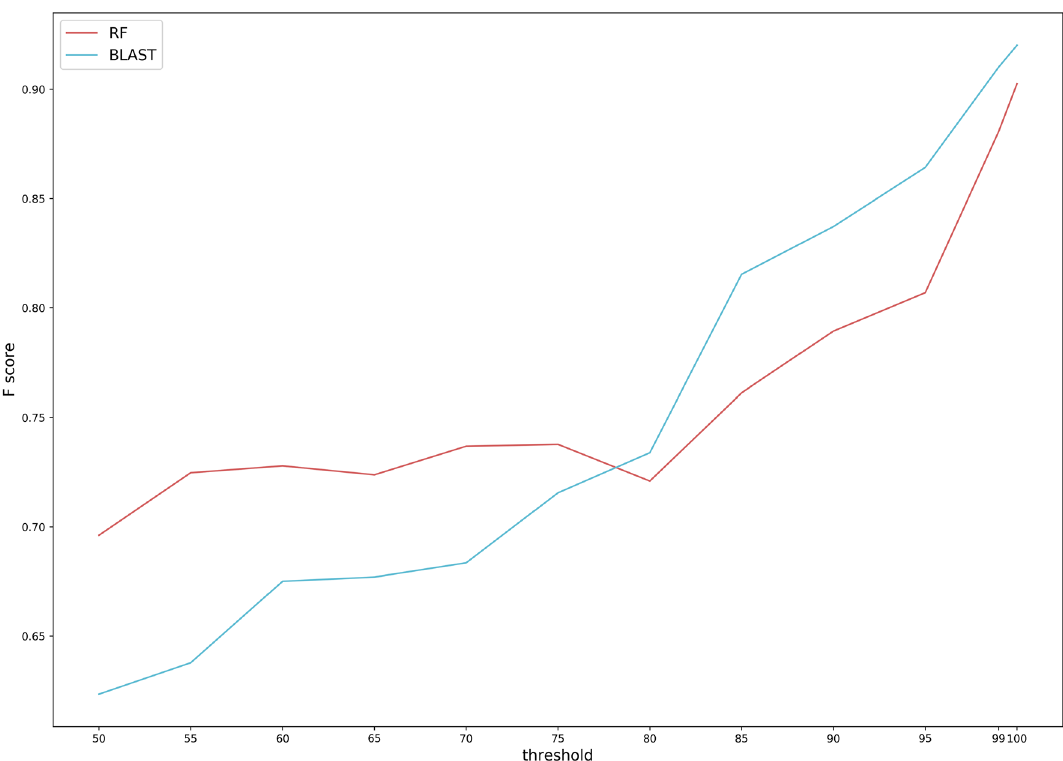
Figure 8. Computed F1 scores of the final Random Forest (RF) model and BLASTp in a Leave-One-Group-Out Cross-Validation (LOGOCV) across different thresholds for sequence similarity. Our final predictive model was compared with BLASTp using a LOGOCV scheme. In every round, a group was held out that was controlled by sequence similarity. The model was trained on all other sequences, after which the bacterial hosts related to the held-out group were predicted. The sequences in this group were also subjected to a local BLASTp search via BioPython against the database without the held-out group 36 . The LOGOCV was repeated for different thresholds of sequence similarity in the dataset that controlled the grouping in the cross-validation (i.e. the lower the threshold, the more sequences were grouped into the held-out group, leaving fewer sequences